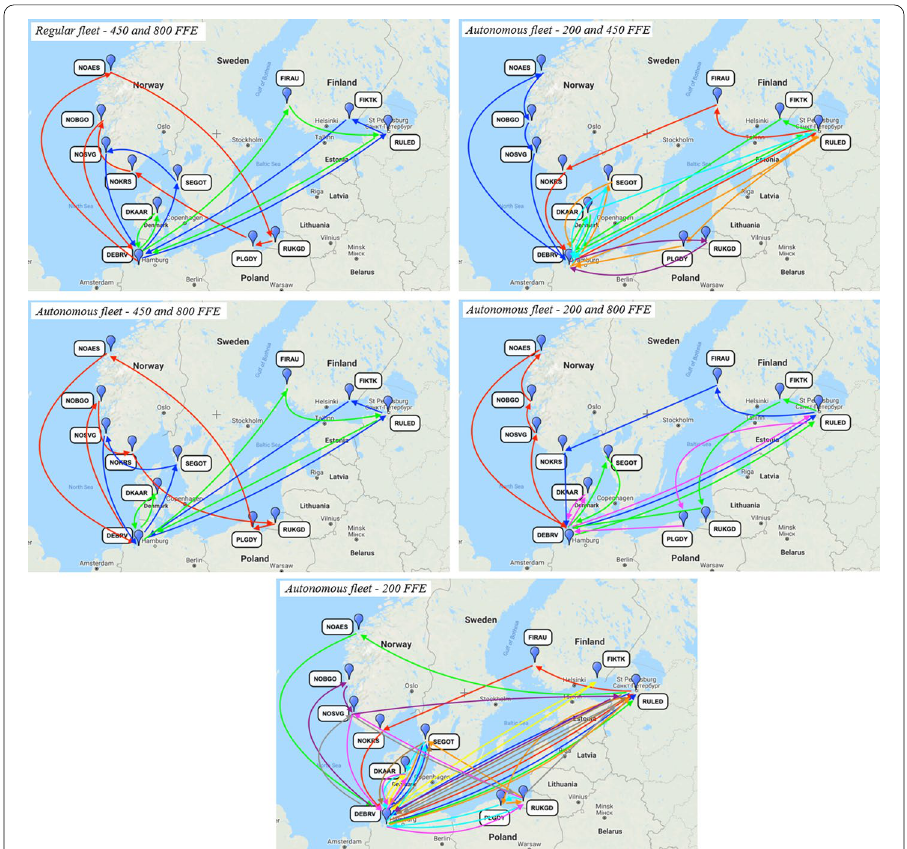
Fig. 2 Routes obtained for the different